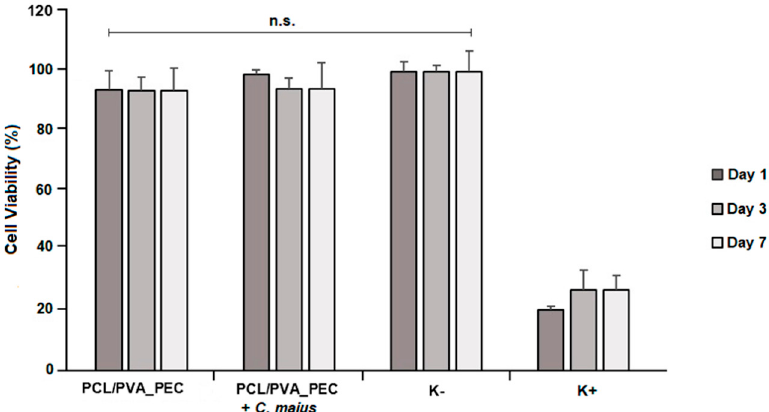
Figure 6. Evaluation of the NHDF cell after 1, 3, and 7 days in direct contact with the produced electrospun PCL/PVA_PEC nanofibrous meshes with and without C. majus extract. (“n.s.” indicates not significant ( p > 0.05)).